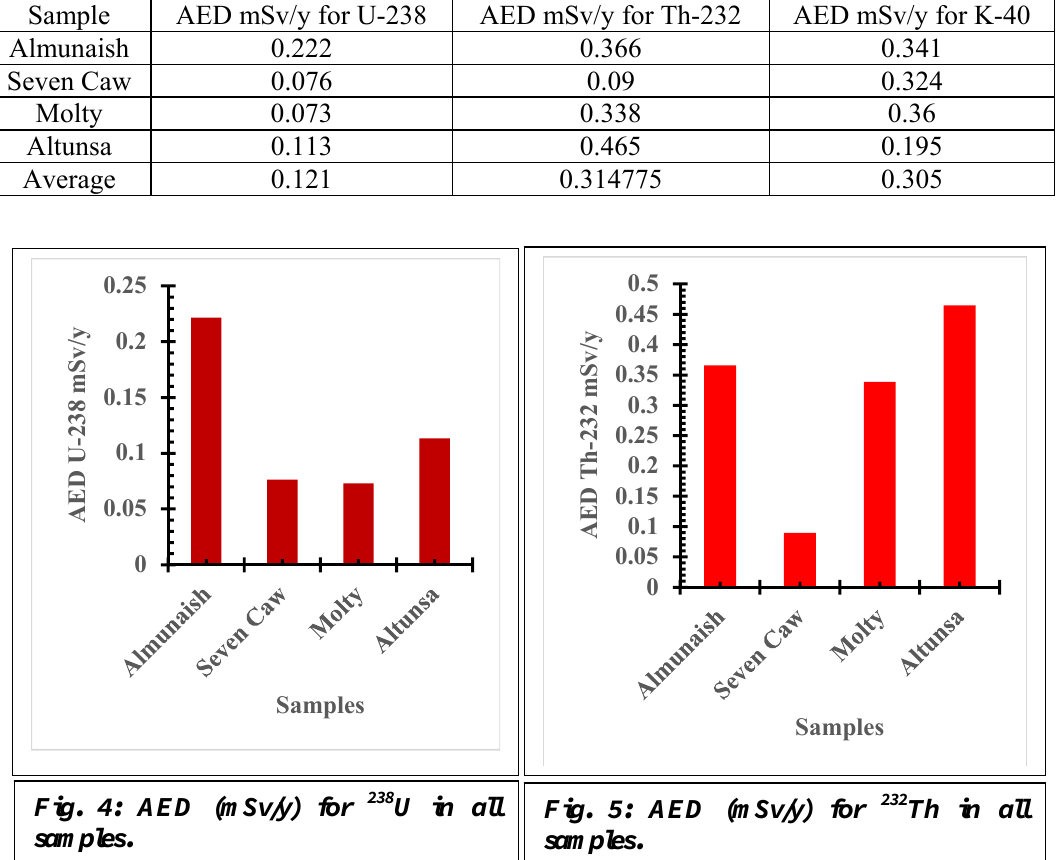
Fig. 5: AED (mSv/y) for 232 Th in all